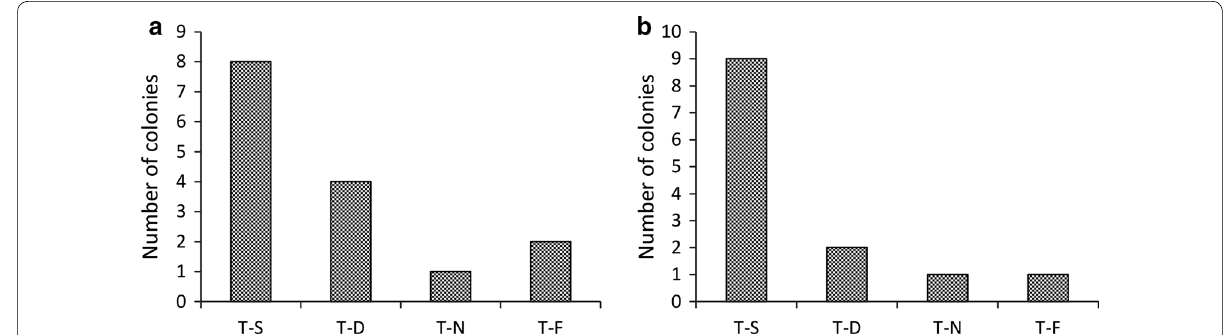
Fig. 4 Graphs showing the number and patterns of the bacterial colonies appearing on the kanamycin-supplemented plates during the deletion of rpoN from E. coli BL21 and upp from B. subtilis 168 using the improved VFAE protocol. a Colonies of E. coli BL21. b Colonies of B. subtilis 168. T-S, single crossover mutant; T-D, double crossover mutant; T-N, wild-type pattern; T-F, failed